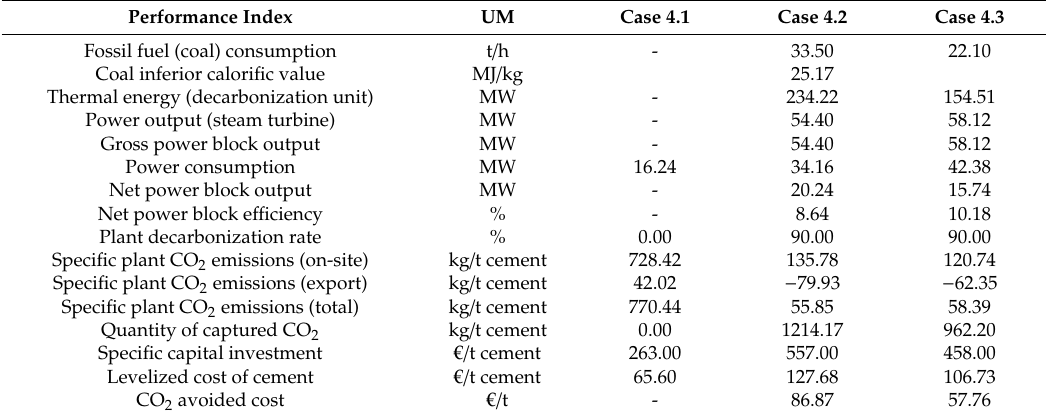
Table 6. Cement plants techno-economic and environmental performance